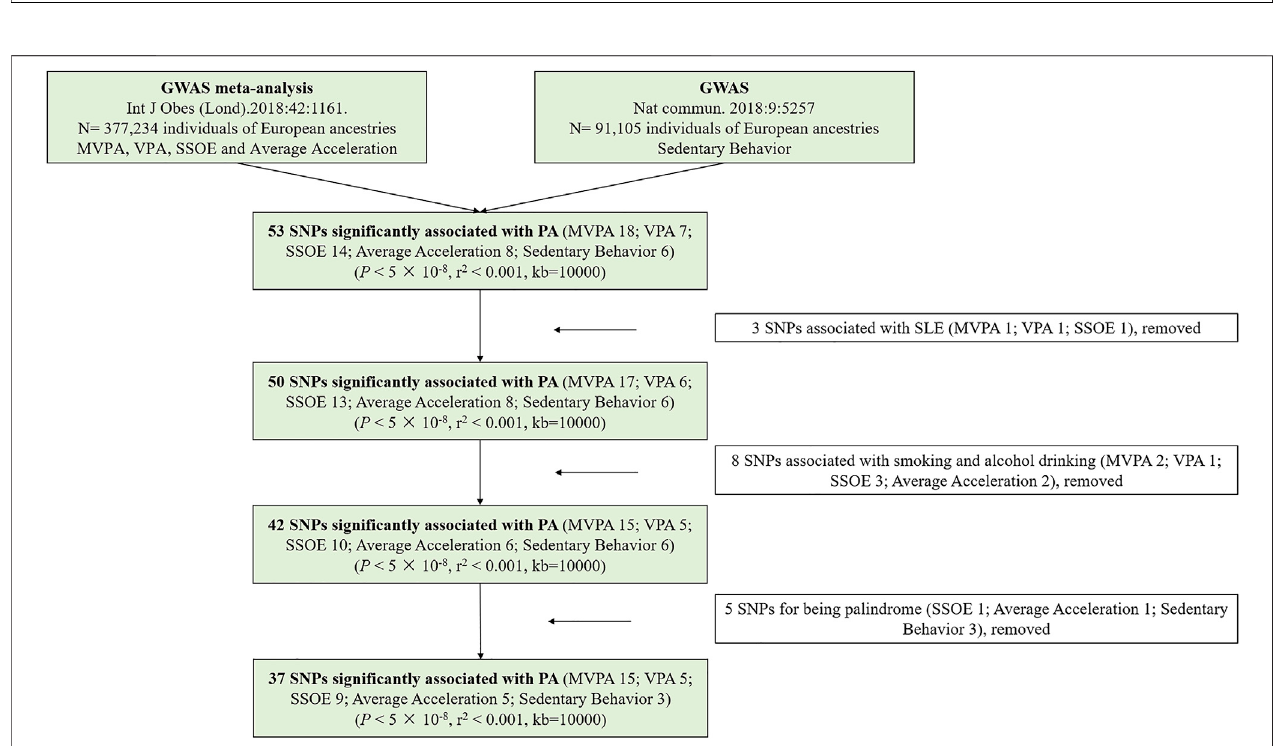
FIGURE2| The fl owchartofinstrumentalvariablesselection.Abbreviations:PA,physicalactivity;GWAS,genome-wideassociationstudy;SNPs,singlenucleotide polymorphisms; MVPA, Moderate-to-vigorous physical activity; VPA, vigorous physical activity; SSOE, strenuous sports or other exercises.